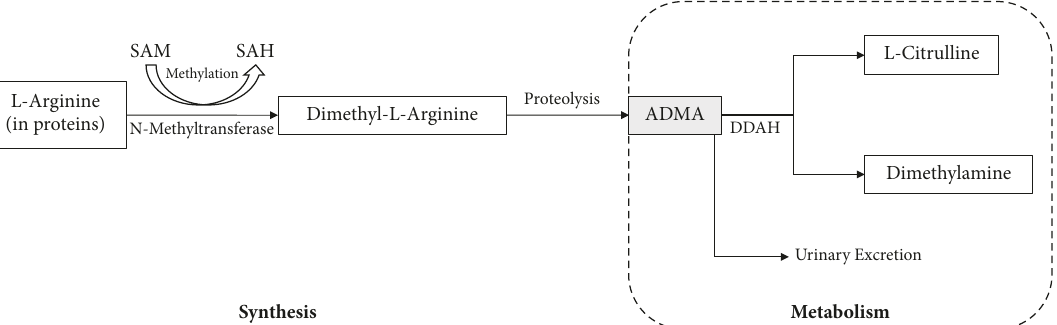
Figure 11: Overview of the synthesis and metabolism of ADMA. Synthesis of ADMA involves the methylation of arginine residues with the help of N-methyltransferase (protein arginine N-methyltransferases, PRMTs) which converts the methyl donor S-adenosylmethionine (SAM) to S-adenosylhomocysteine (SAH) followed by proteolytic breakdown of the proteins, which generates ADMA and N-monomethyl- L-arginine (L-NMMA). Elimination of ADMA is partly achieved via urinary excretion. However, ADMA is mainly eliminated through its metabolism to citrulline and dimethylamine by the enzyme dimethylarginine dimethylaminohydrolase (DDAH) [145].